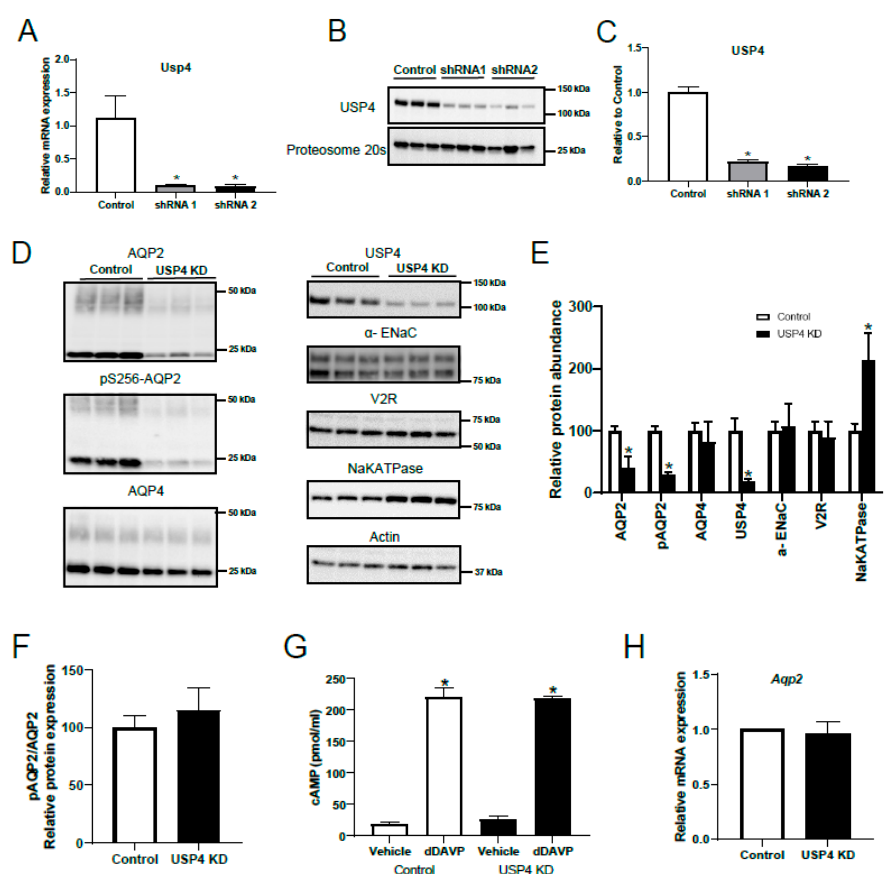
Figure 4. Stable USP4 knockdown in mpkCCD14 cells decreases AQP2 abundance. mpkCCD14